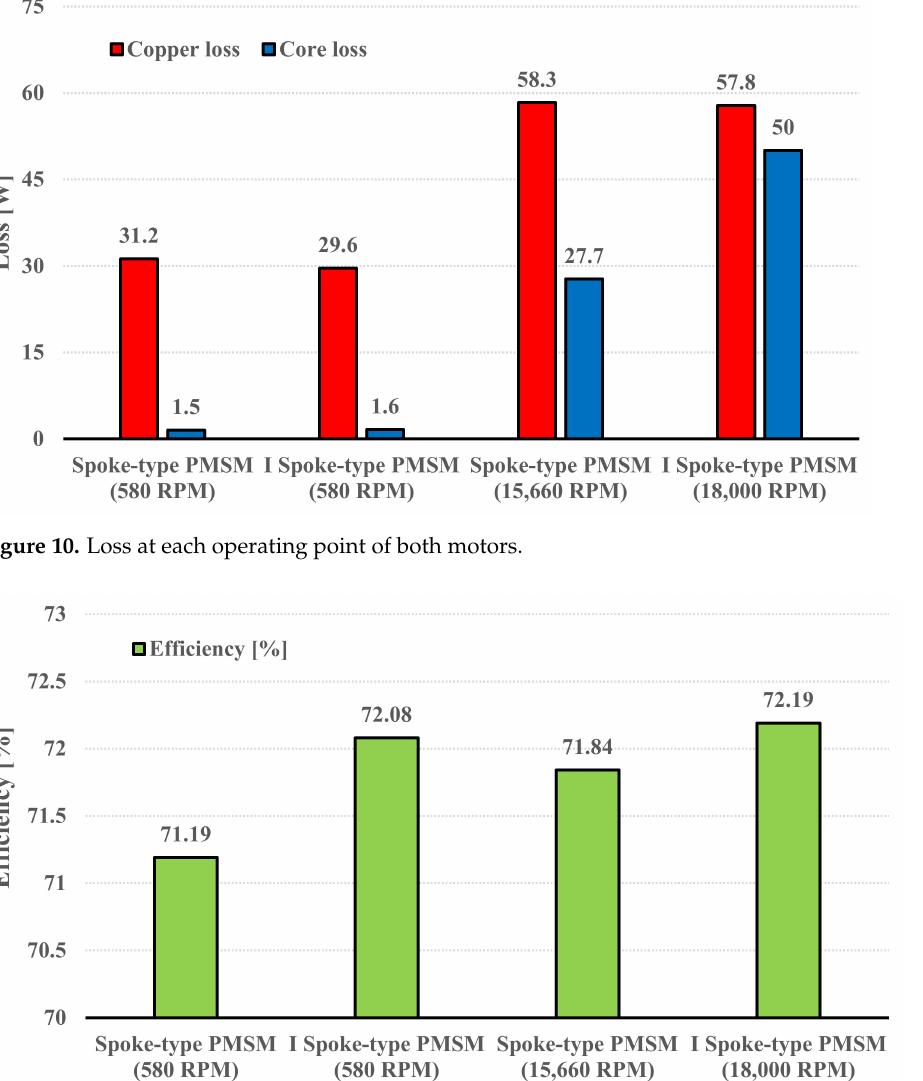
Figure 11. Efficiency at each operating point of both